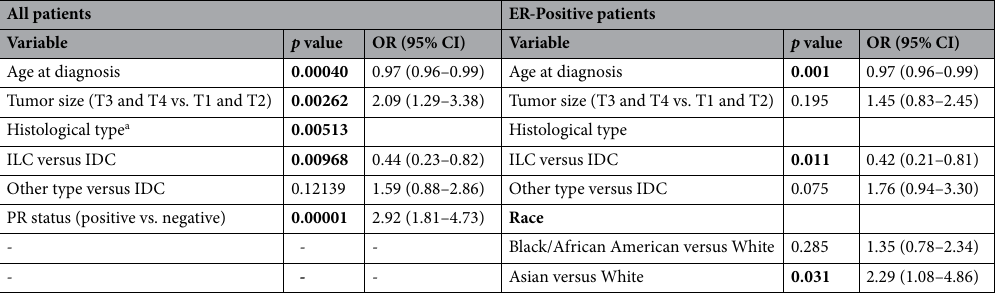
versus normal, non-mutant versus normal and non-mutant versus mutant tumors, respectively. Volcano plots are shown in Fig. 1. The most up and down-regulated DEGs in three categories of comparison are listed in Table 4. MYH2 and CKM in mutant versus normal and non-mutant versus normal and SMR3B in mutant versus non-mutant were the top down-regulated genes. The top up-regulated genes were MUC2 , S100A7A and ALDOB in mutant versus